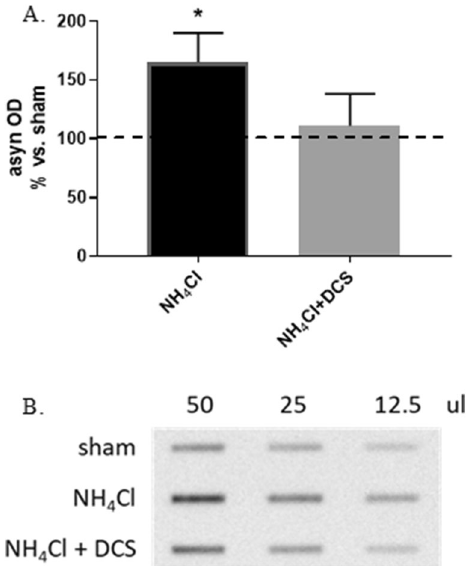
Figure 8. Effect of DCS on extracellular soluble asyn levels in culture media of cells treated with NH 4 Cl (10 mM, 24 h); culture media were collected 17 h after DCS (R17); the effect of NH 4 Cl alone on extracellular soluble asyn was also shown. DCS counteracted the NH 4 Cl-induced increase of extracellular levels of soluble asyn ( A , B ). ( A ) Histogram showing the levels of extracellular soluble asyn expressed as optical density (OD) in cells treated with NH 4 Cl alone or NH 4 Cl and DCS. ( B ) Representative Dot blot image showing immunoreactivity for extracellular soluble asyn in cells exposed to sham and cells treated with NH 4 Cl alone or NH 4 Cl and DCS (volume range: 50–12.5 ul). Full-length blot is presented in Supplementary M&M. (N = 3; *p < 0.05 vs.